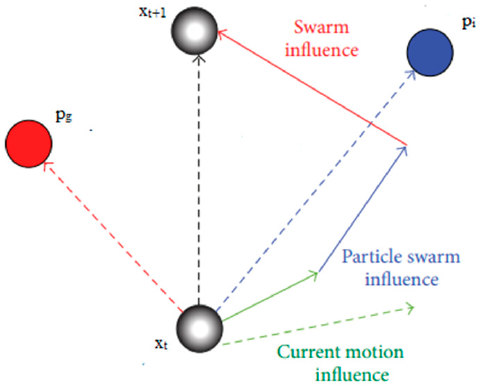
Figure 2. Illustration of particle’s position after being subjected to PSO.